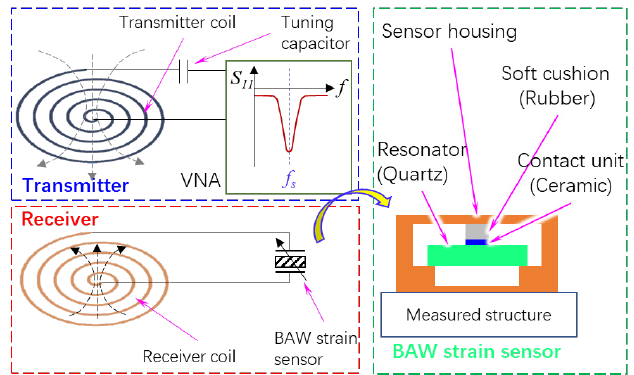
Figure 1. Schematic of a BAW passive wireless strain sensor.